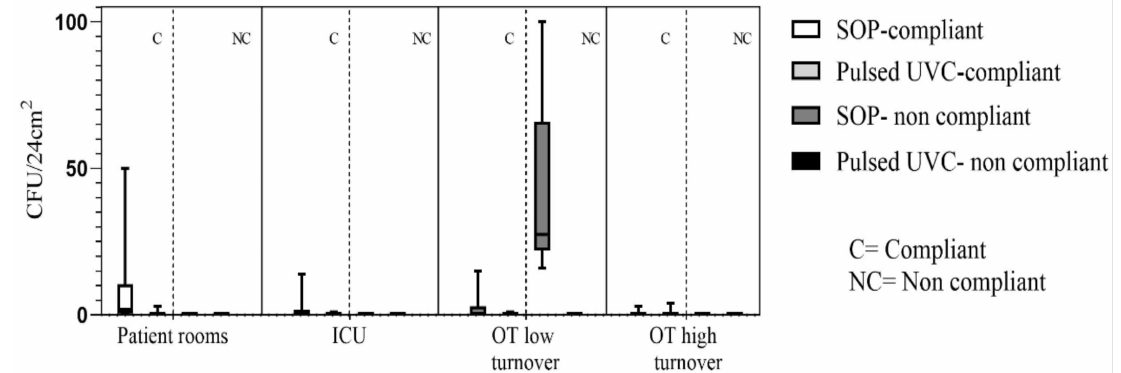
Figure 1. Median, lower, and higher values of the bacterial load detected in each hospital setting, distinguishing compliant on non-compliant values. Note: ICU—Intensive Care Unit; OT—Operative Theatre; C&D—Cleaning and Disinfection; SOP—Standard Operative Procedure; IQR—Interquartile